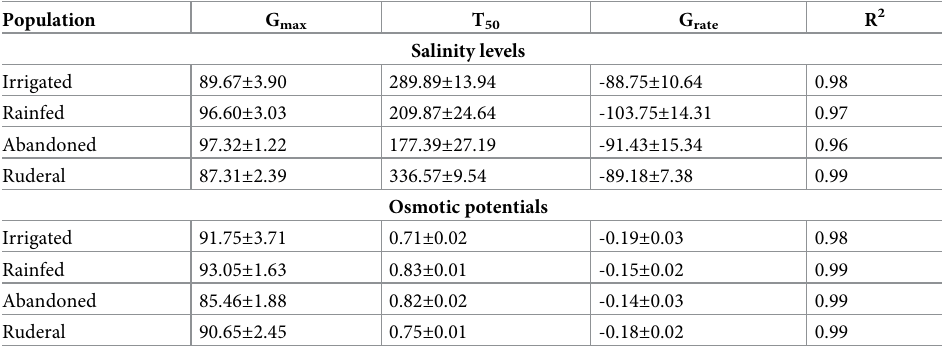
Abandoned Ruderal 90.65 ± 2.45 0.99 Parameter estimates: G max = maximum germination (%), T 50 = time to reach 50% of the maximum germination (days), G rate = slope of three parametric sigmoidal function fitted to model the germination of different populations of Erect horseweed. R 2 represents the model goodness of